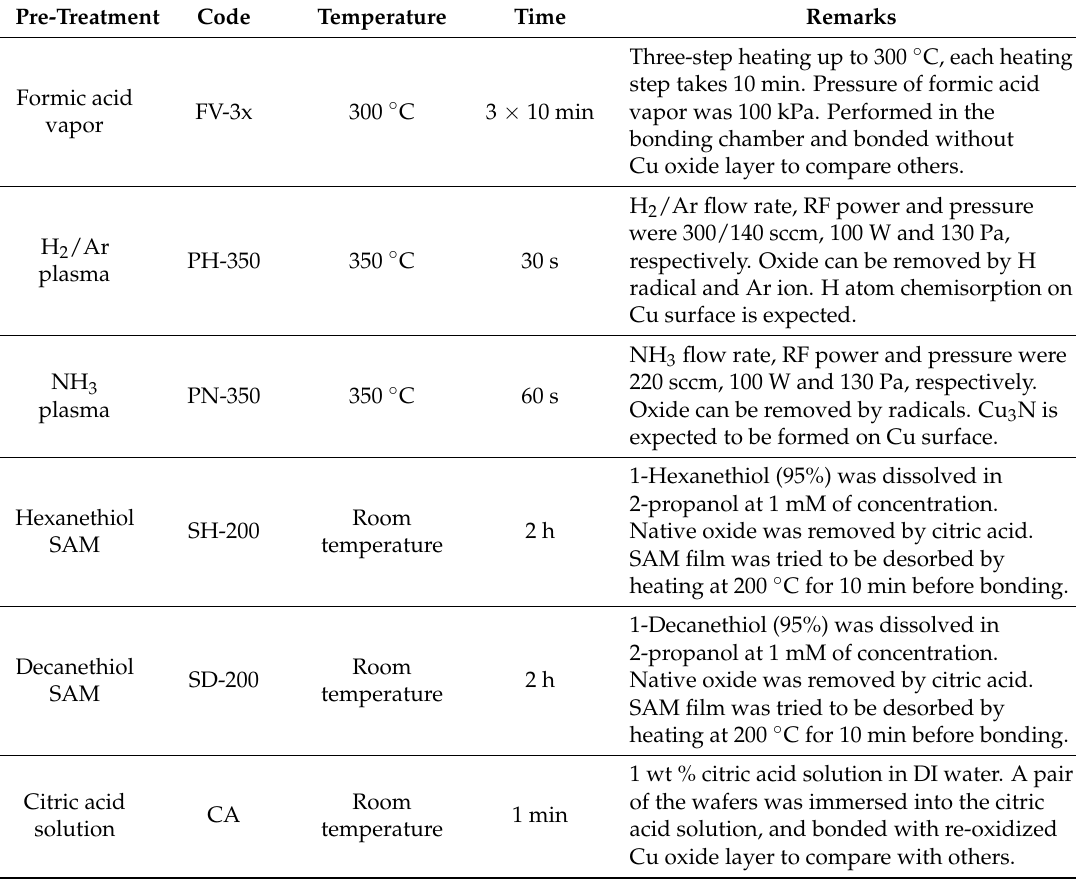
Table 1. Pre-treatment conditions of Cu-Cu thermo-compression